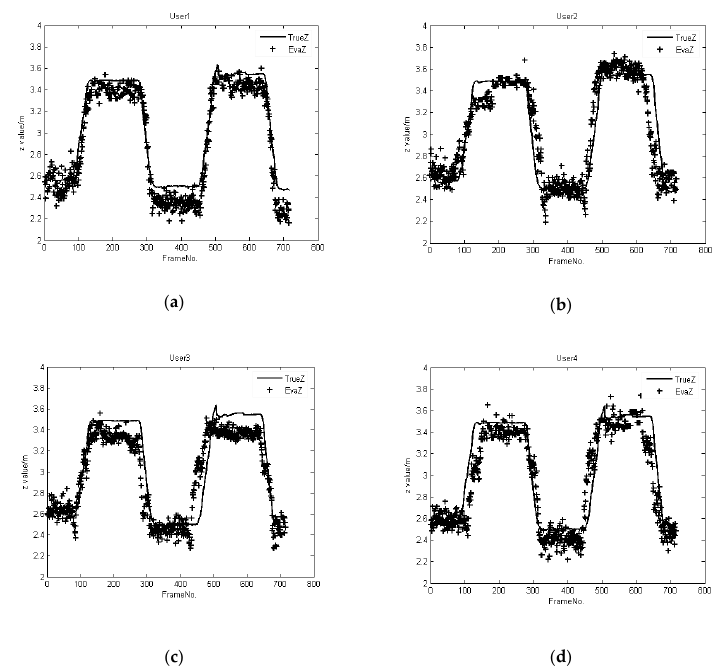
Figure 11. Comparison between trajectories as tracked by a person’s skeleton as opposed to computed using shadows for Path 1, where Users 1, 2, 3, and 4 are randomly selected human participants, and their tracking results correspond to ( a – d ), respectively.